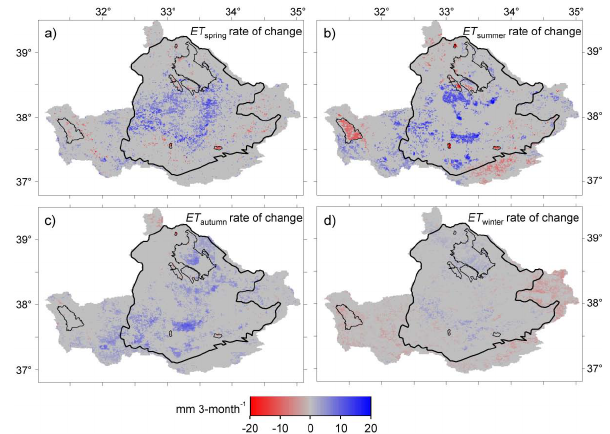
Fig. 7. The distributions of the magnitudes of the trends in the sea- sonal ET in the Konya Basin for (a) spring, (b) summer, (c) autumn, (d)